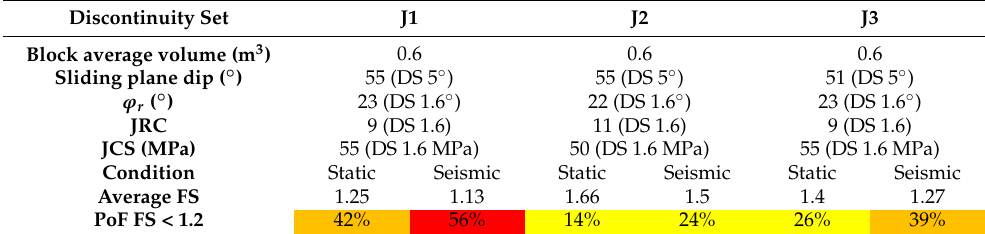
Table 9. Probabilistic stability analysis results for planar sliding: J1, J2, and J3 sets.